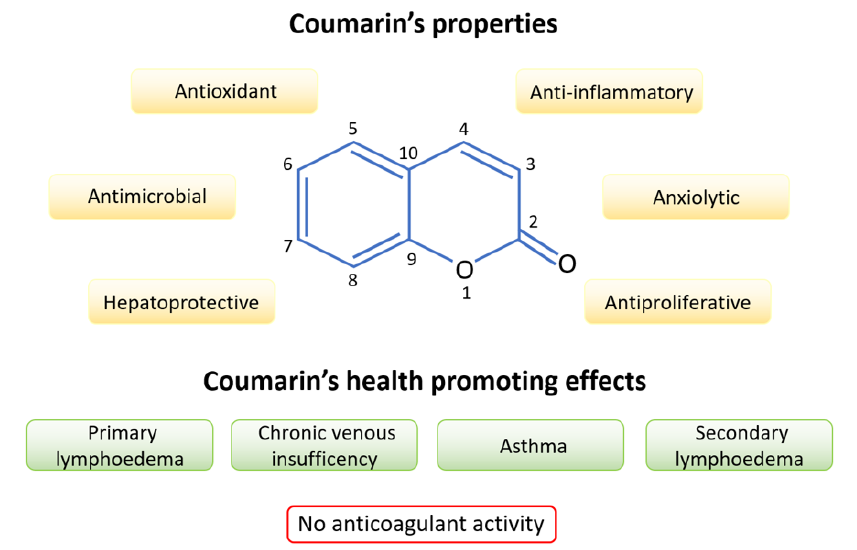
Figure 2. Coumarin’s biological properties and therapeutical applications.